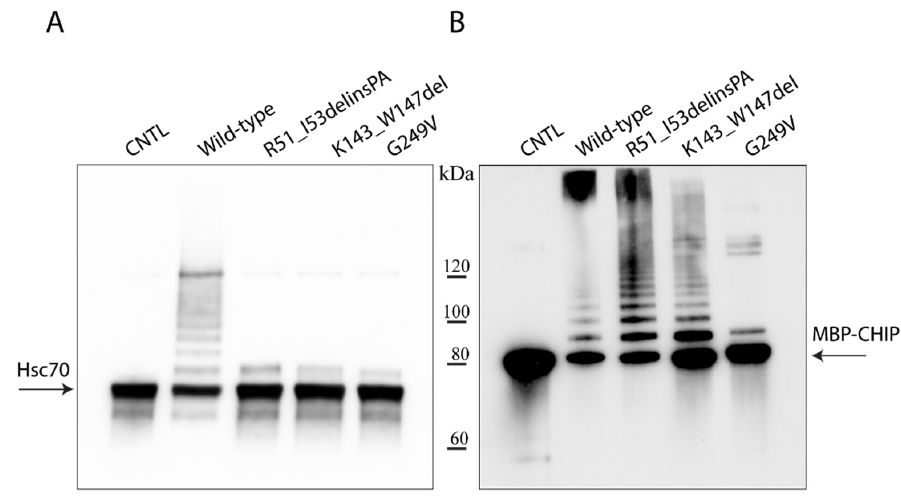
Figure 2. Ubiquitination activity of wild-type and mutant MBP–CHIP proteins. In vitro ubiquitination activity test was performed on MBP–CHIP recombinant proteins using Hsc70 ( A ) and MBP–CHIP ( B ) as the substrates. A separate wild-type reaction without ubiquitin was used as the negative control (CNTL) for each assay.